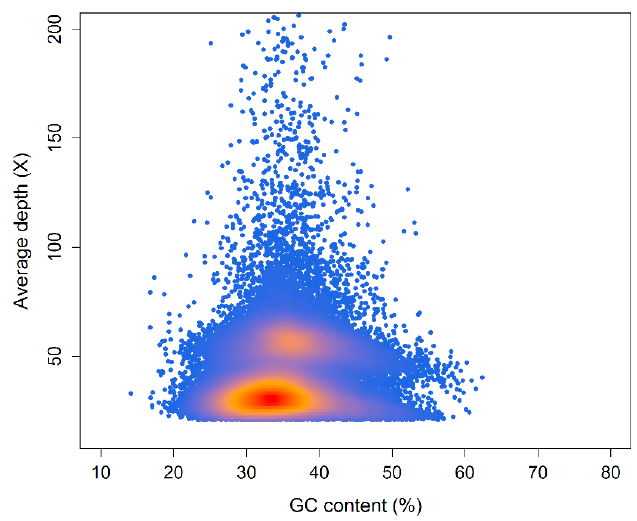
Figure 4. GC depth distribution of the B. platyphylla genome (after filtration).